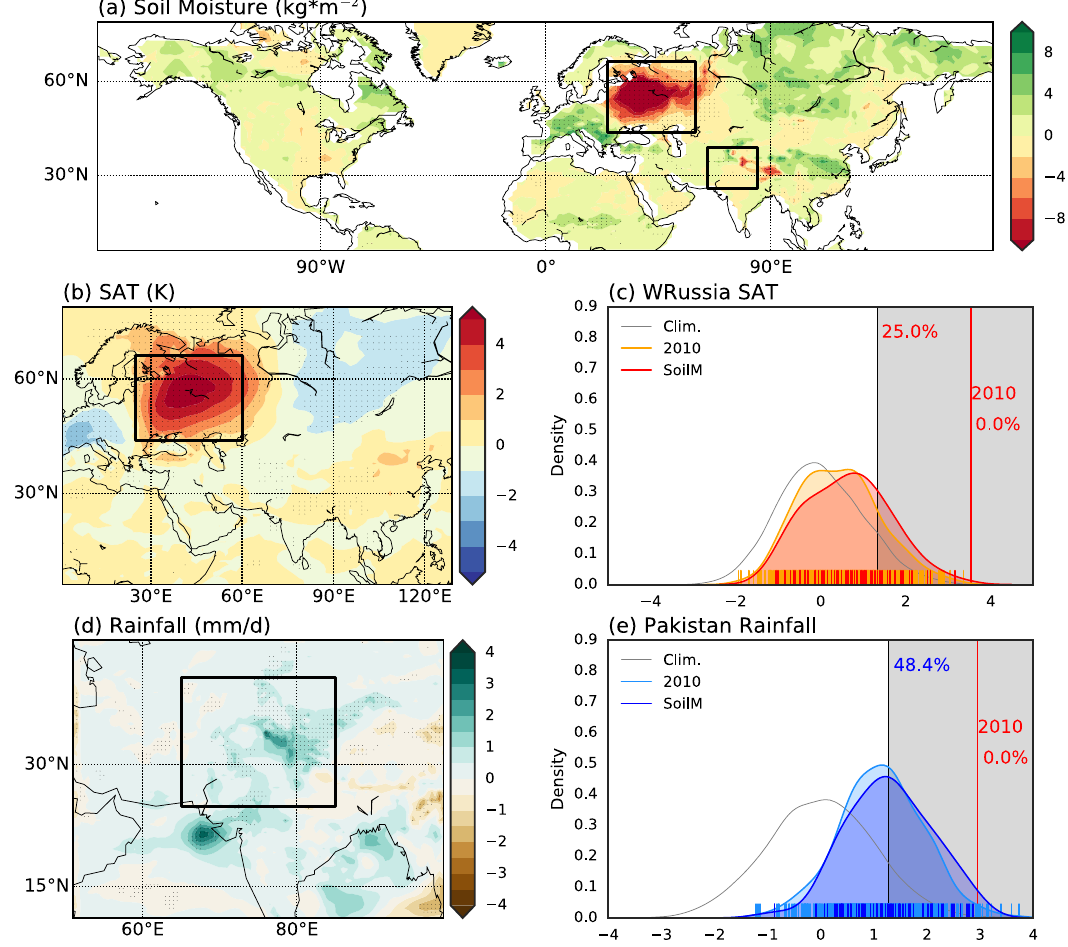
Fig. 7 Soil moisture in June. Panel a : composites of soil moisture for ensemble members selected with soil moisture signal over WRussia signal below the 10th percentile (65 ensemble members out of 649) during June (Glob2010 | soilM). Panel b : composites of SAT for Glob2010 | soilM and also exceeding the 90th WRussia SAT index (GlobClim) percentile (black solid line in panel c ). Panel c : PDF of WRussia SAT index for Glob2010 (orange solid line) and for Glob2010 | soilM (red solid line). The rug shows the exact position of the data. Panel d : composites of regional Rainfall for Reg2010 | soilM and also exceeding the 90th Pakistan regional Rainfall index (RegClim) percentile (black solid line in Panel e ). Panel d : PDF for Pakistan Rainfall index in Reg2010 (solid light blue line) and for Reg2010 | soilM (blue solid line). Both in panels c and e vertical solid black line show the 90th percentile calculated from the climatological PDF and vertical solid red lines show the 2010 threshold (expressed in units of s.d.) together with the percentage of events that exceed this threshold in the soilM sub-selection. Anomalies are calculated based on the Glob2010 (or Reg2010 for Rainfall) ensemble mean to differentiate from the impact of 2010 global SST. The stippling represents signi fi cant grid points at α = 0.05 and is calculated applying a Student- t test. The smoothing of the curve is done using a Gaussian kernel to produce a continuous density